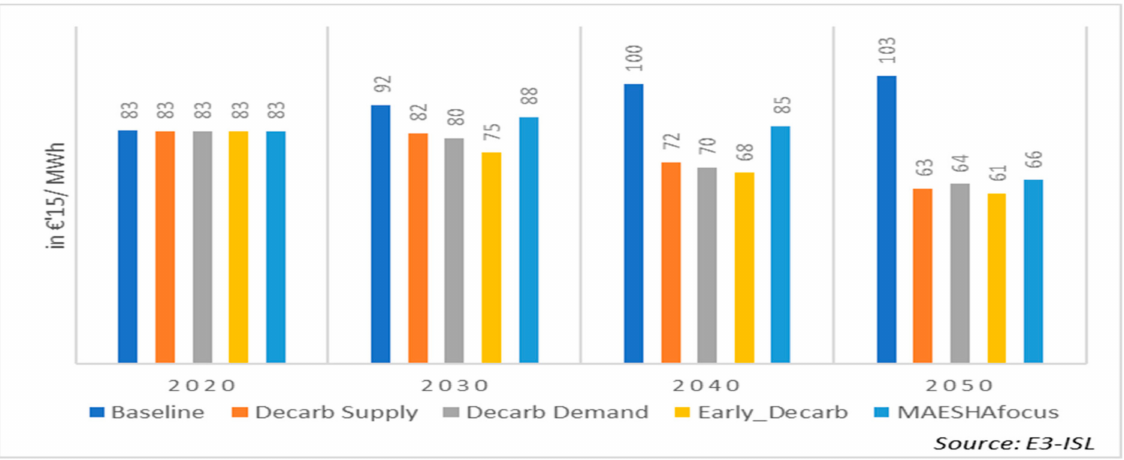
higher ETS carbon pricing.